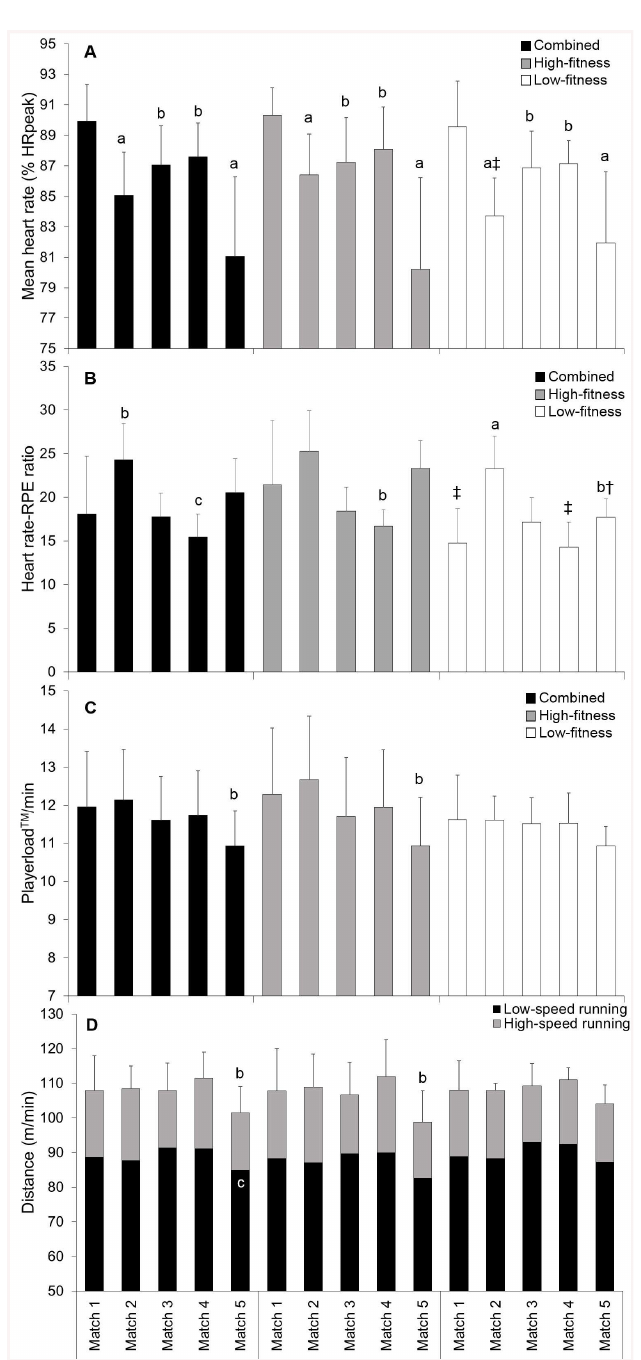
Fig 2. Changes in mean HR (A), HR-RPE ratio (B), Playerload TM /min (C) and distance/min (D) during the tournament for players grouped into high- and low-fitness groups. a , b and c indicate a large, moderate and small difference compared to match 1, respectively. † and ‡ indicate a large and moderate difference compared to the high-fitness group, respectively.